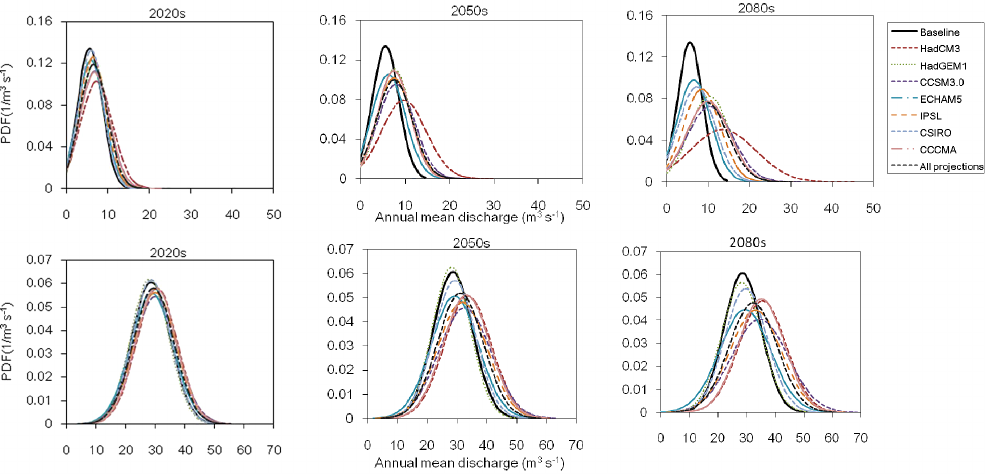
Figure 8. Probability density functions of annual mean discharge for seven GCM projections for the 2020s, 2050s and 2080s time horizons and for the 1961–1990 baseline for the rivers Huangfuchuan (top) and Xiangxi